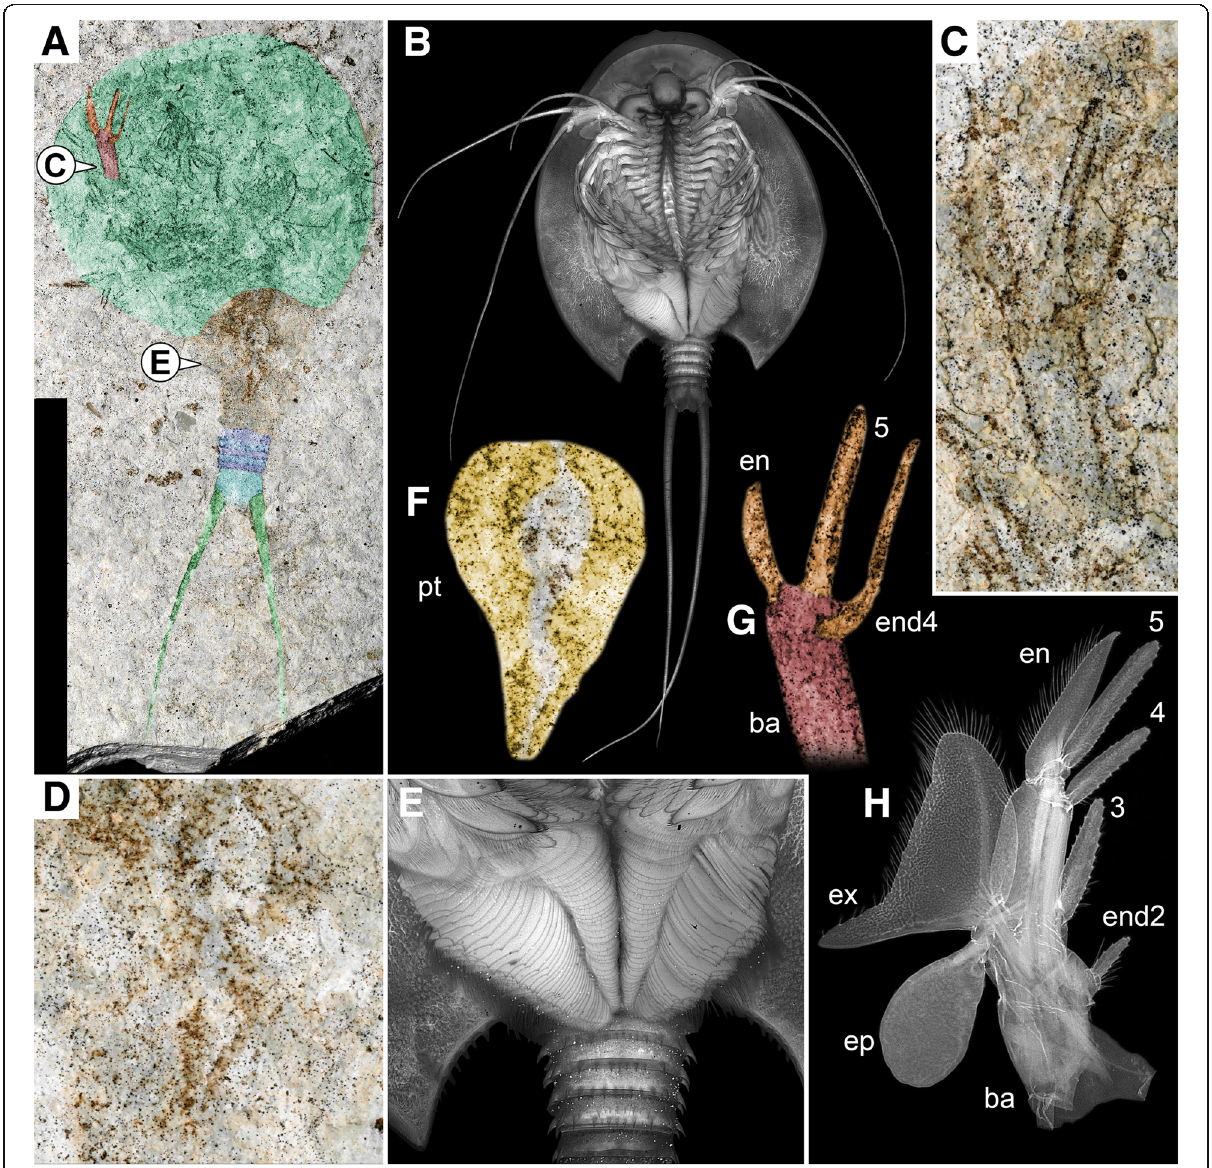
Fig. 2 Comparison between Notostraca oleseni and extant Triops cancriformis : a Overview of Notostraca oleseni ; b Overview of extant Triops cancriformis ; c Anterior thoracopod of Notostraca oleseni ; d Posterior thoracopods of Notostraca oleseni ; e Posterior thoracopods of extant Triops cancriformis ; f Posterior thoracopods of Notostraca oleseni , colour marked, detail of d ; g Anterior thoracopod of Notostraca oleseni , colour marked, detail of c ; h Anterior thoracopod of extant Triops cancriformis ; ba, basipod; en, endopod; end2 – 5, endite 2 – 5 (endite 1 not visible on this image); ep, epipod; ex, exopod; pt, posterior